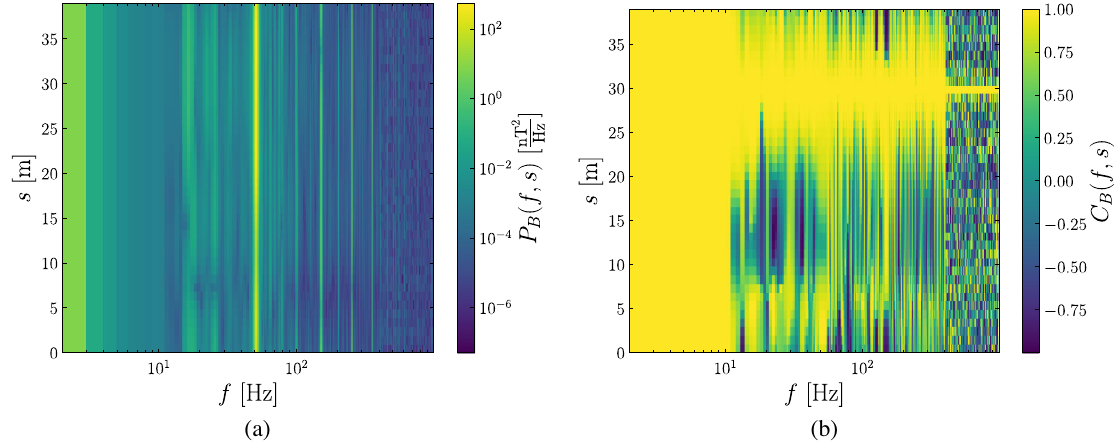
FIG. 8. A sample from the generator of stray fields. (a) PSD P B ð f; s Þ (RH scale) vs location s (LH scale) and frequency f and (b) correlation C B ð f; s Þ (RH scale) vs location s (LH scale) and frequency f . The correlation was calculated with respect to the stray field at s ¼ 30